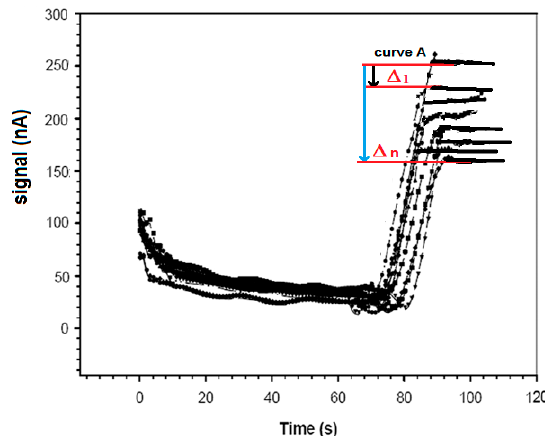
Figure 4. Trend in amperometric responses in the absence of peroxidase conjugated (curve A) and another curve in the presence of enzyme for H 2 O 2 , obtained by the procedure described in Section 2.4.3.